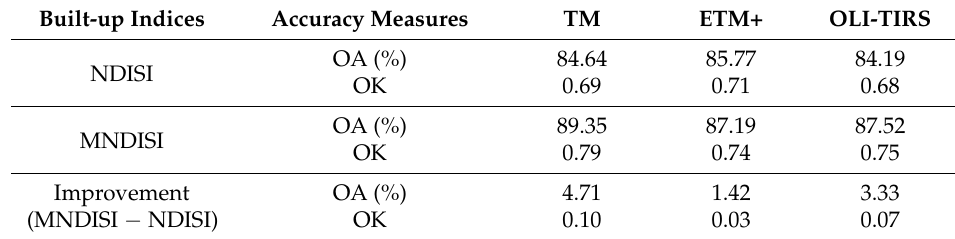
Table 2. Accuracy comparison between the NDISI and MNDISI classifications with the three summer images.